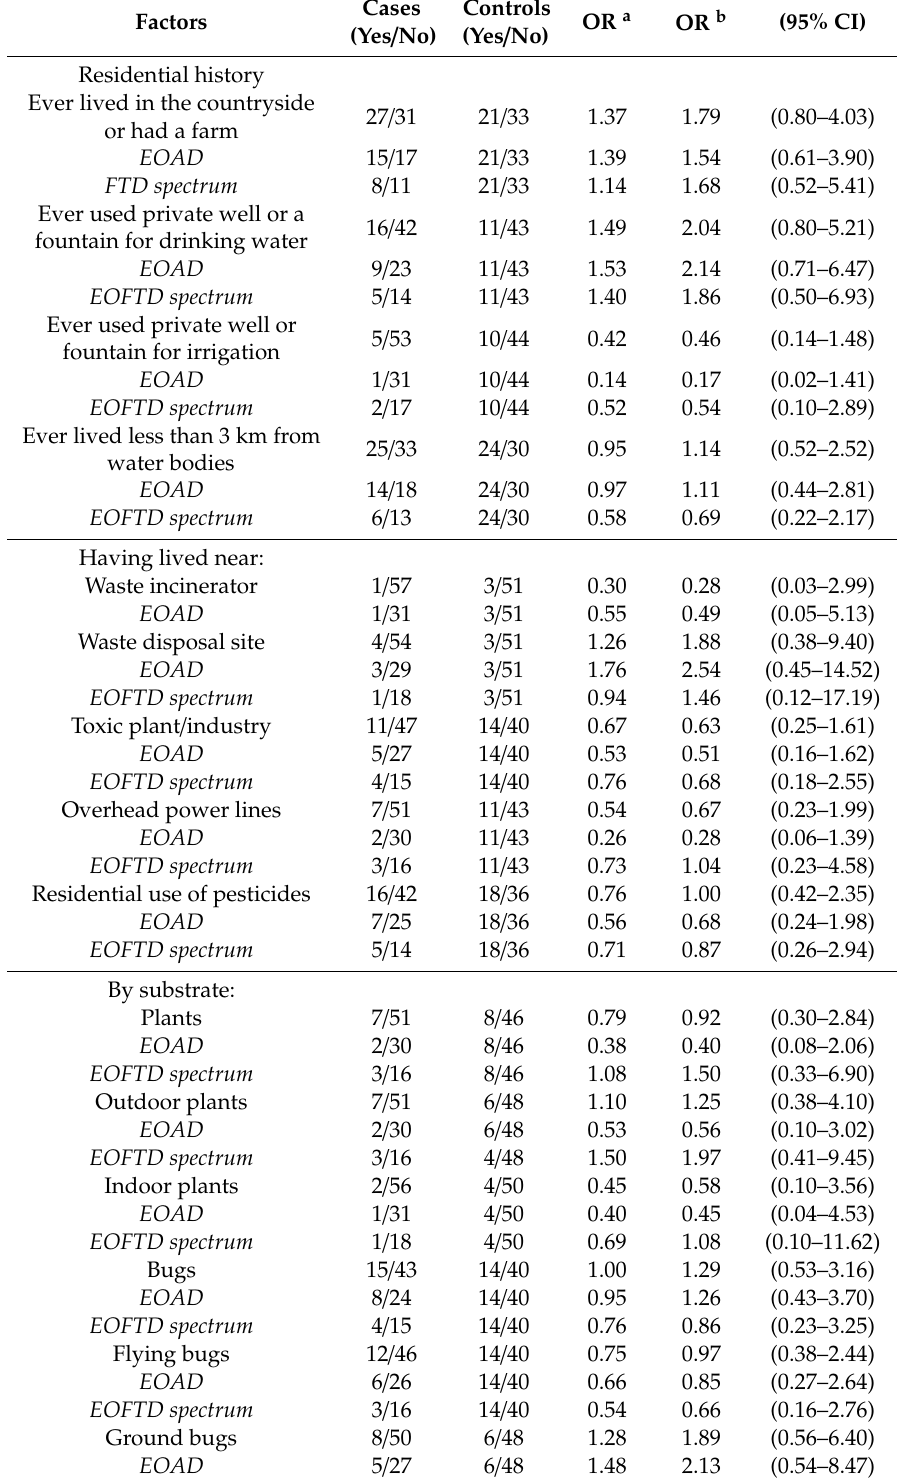
Table 6. Odds ratios (ORs) with 95% confidence intervals (CIs) for early-onset dementia (EOAD, early-onset Alzheimer’s dementia; EOFTD, early-onset frontotemporal dementia) related to residential